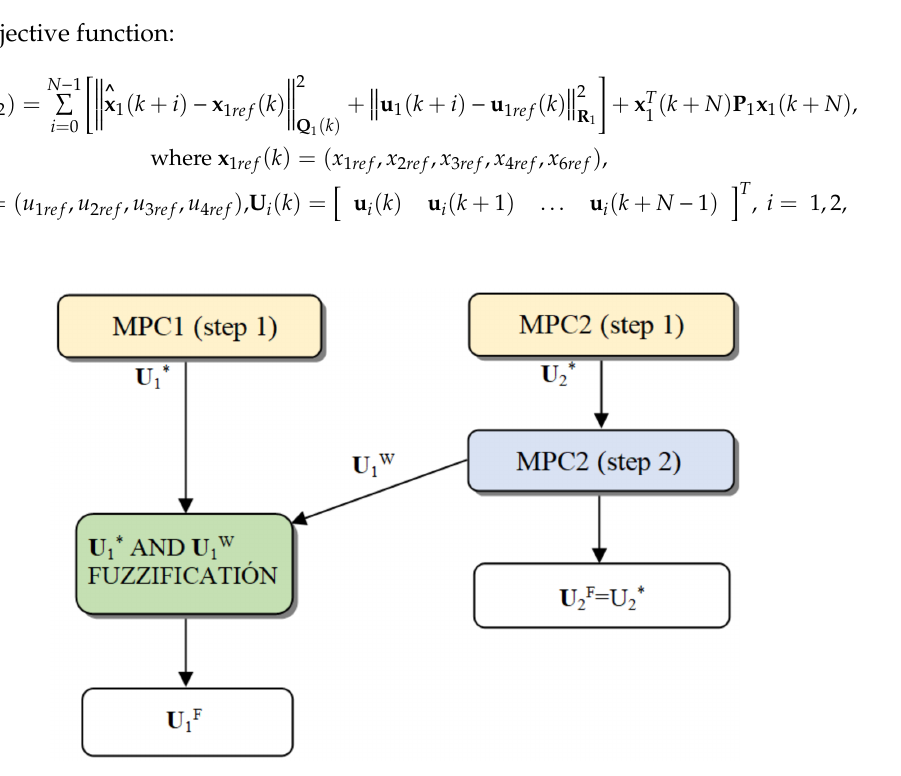
Figure 6. Distributed Model Predictive Control (DMPC)